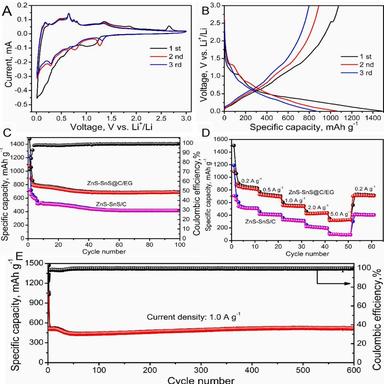
(A) CV curves of ZnS-SnS@C/EG composite at 0.1 mV s − 1 ; (B) Galvanostatic discharge/charge profiles of the ZnS-SnS@C/EG composite; (C) cycling performance and (D) rate capability of ZnS-SnS@C/EG and ZnS-SnS/C composite; (E) Long-term cycling performance of ZnS-SnS@C/EG and ZnS-SnS/C composite at 1.0 A g− 1 .